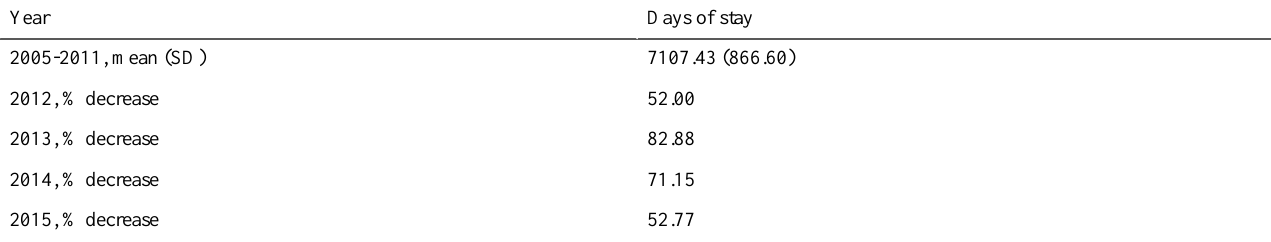
Table 6. Percentage decrease in the number of days of stay for each year from 2012 to 2015 with respect to the mean days of stay from 2005 to 2011 for the Healthcare Complex of